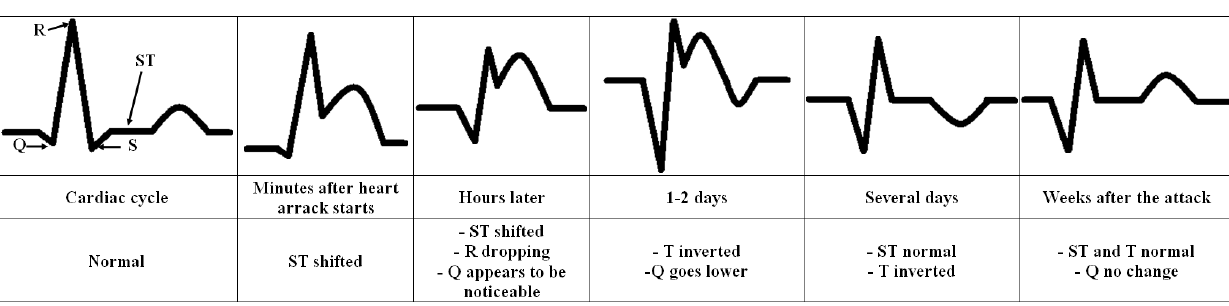
Figure 2. Recorded evolution of ECG waveform showing the pathological disturbances after the heart attack in ST, T and Q parts (basing on the knowledge acquired from [6]). Any pathological change in any stage can automatically be described as an abnormal